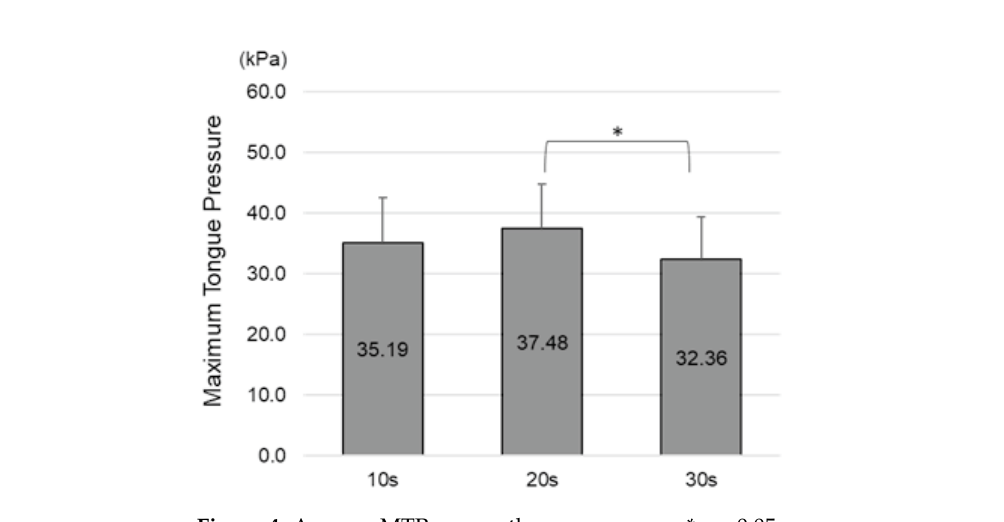
Figure 4. Average MTP among three age groups. * p < 0.05.